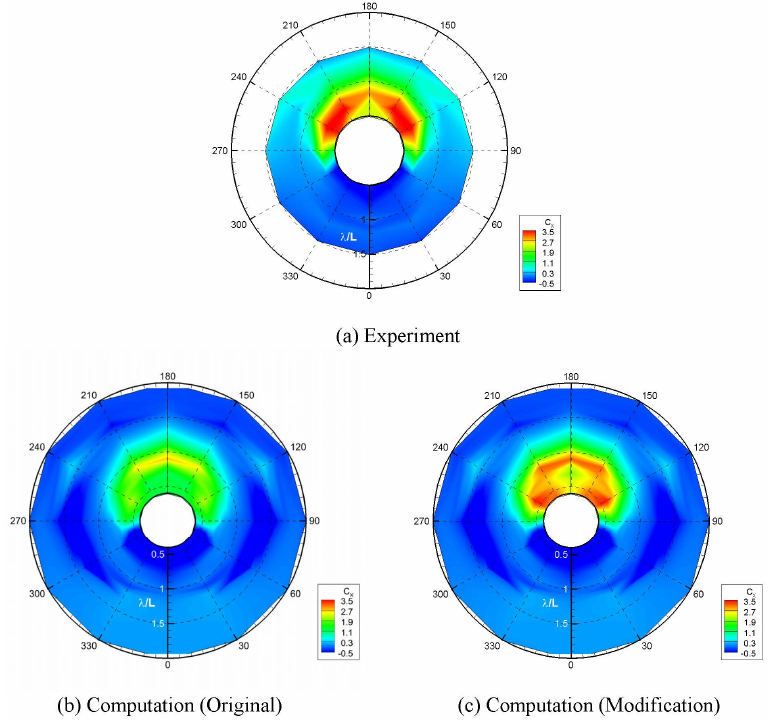
Figure 13. Polar diagram of surge wave drift force: KVLCC2, V = 6